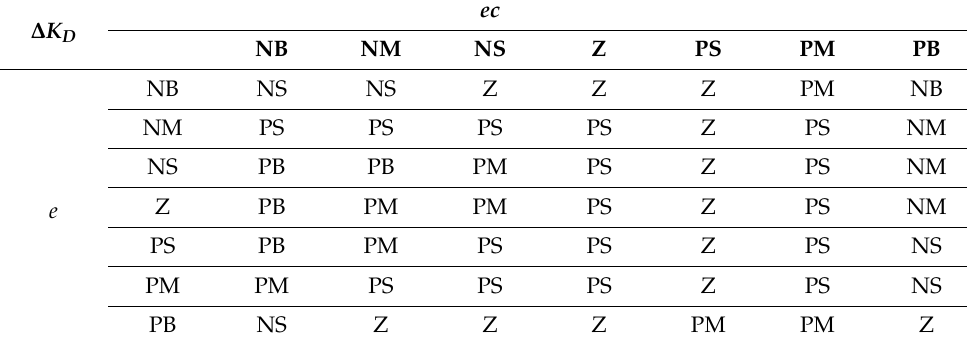
Table 3. Fuzzy control rules for ∆ K D